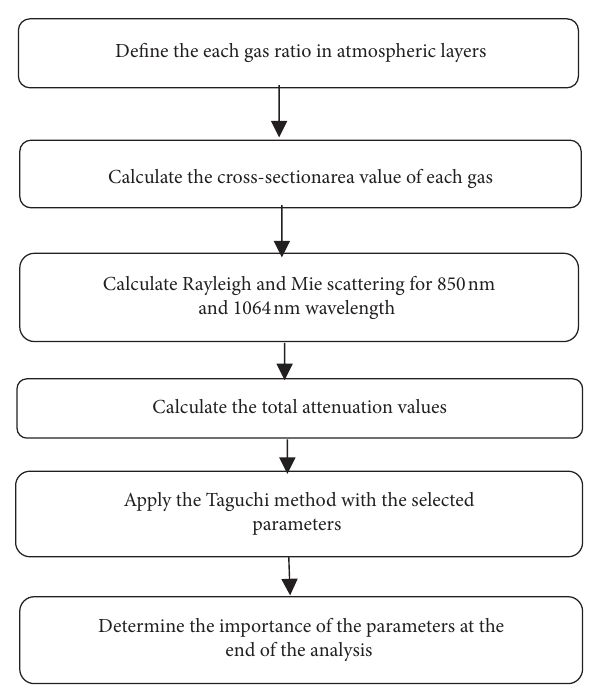
Figure 5: The diagram of the proposed method. Table 6: Free space optics communication scattering and absorption parameters experimental design levels.